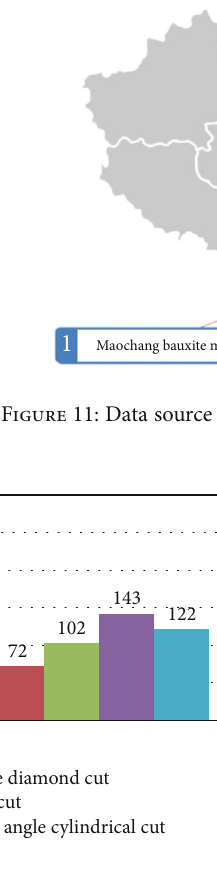
Figure 12: Number of cases under various cutting schemes.